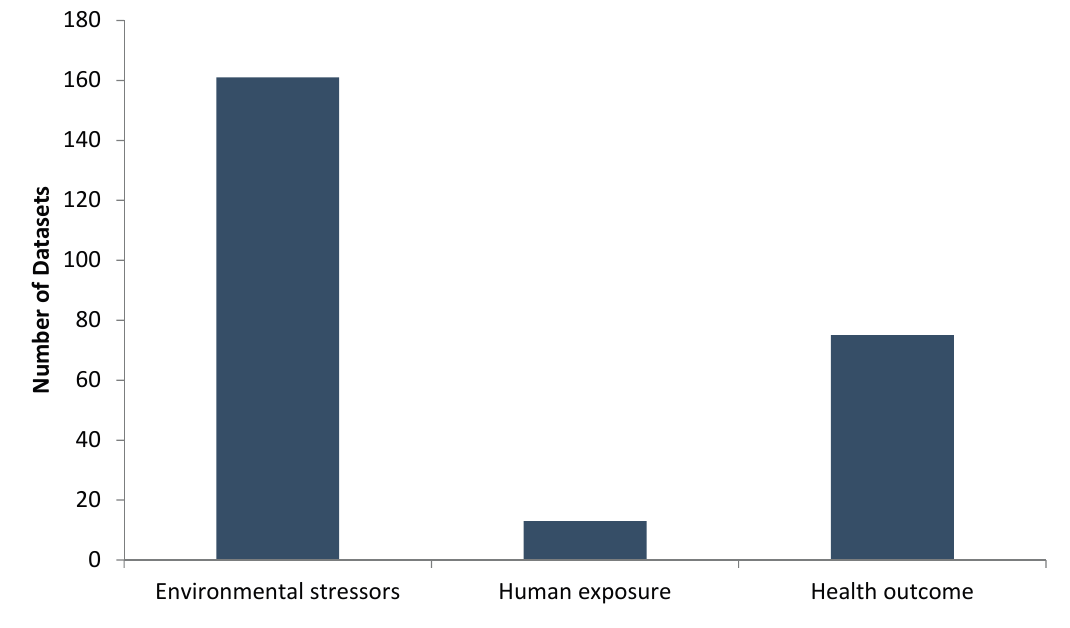
Figure 1. Distribution of identified environment and health